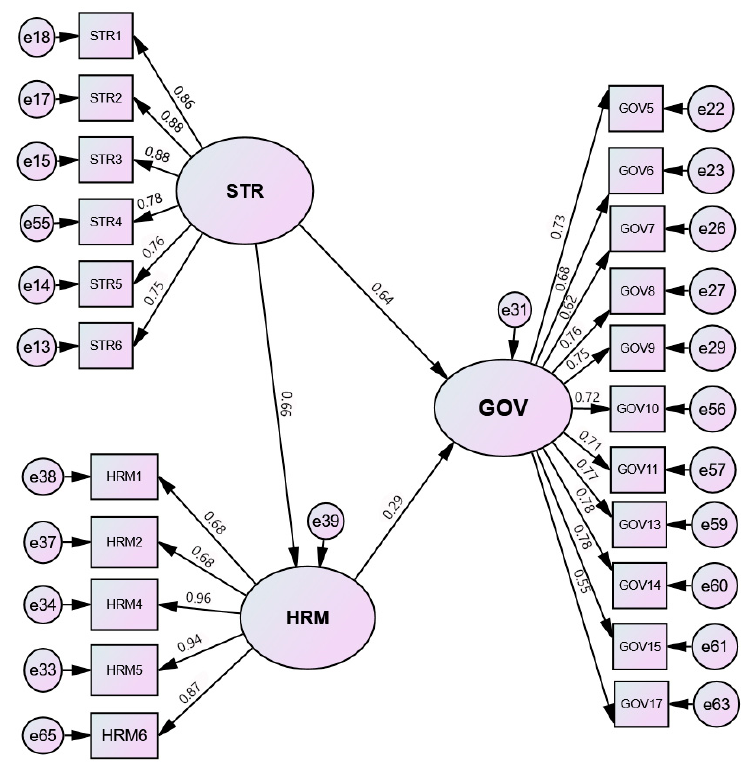
Figure 1. Final research